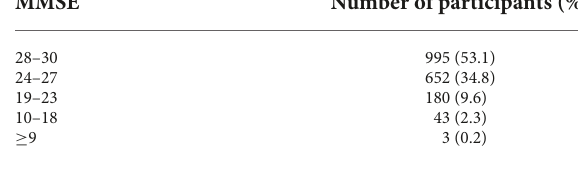
TABLE 3 Distribution of participants’ MMSE